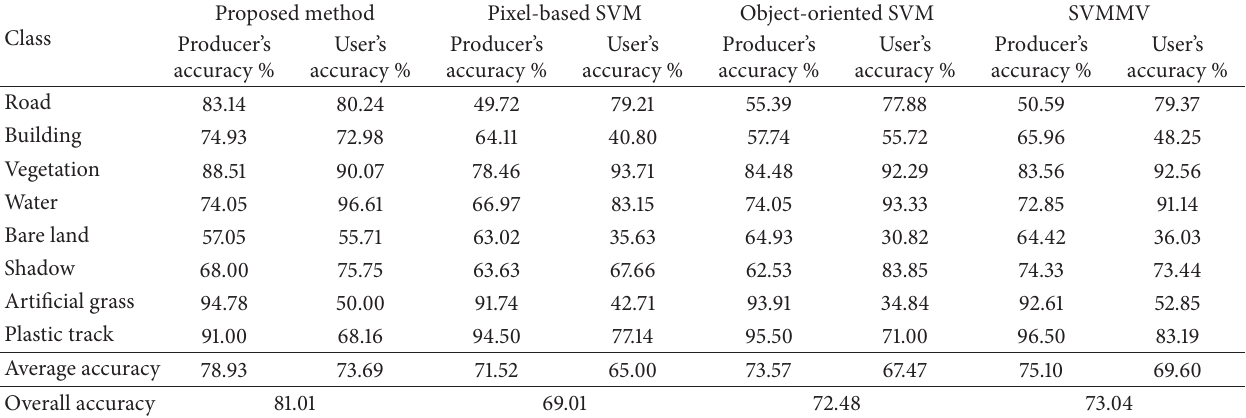
Table 2: Producer and user classification accuracies for QuickBird image classification.